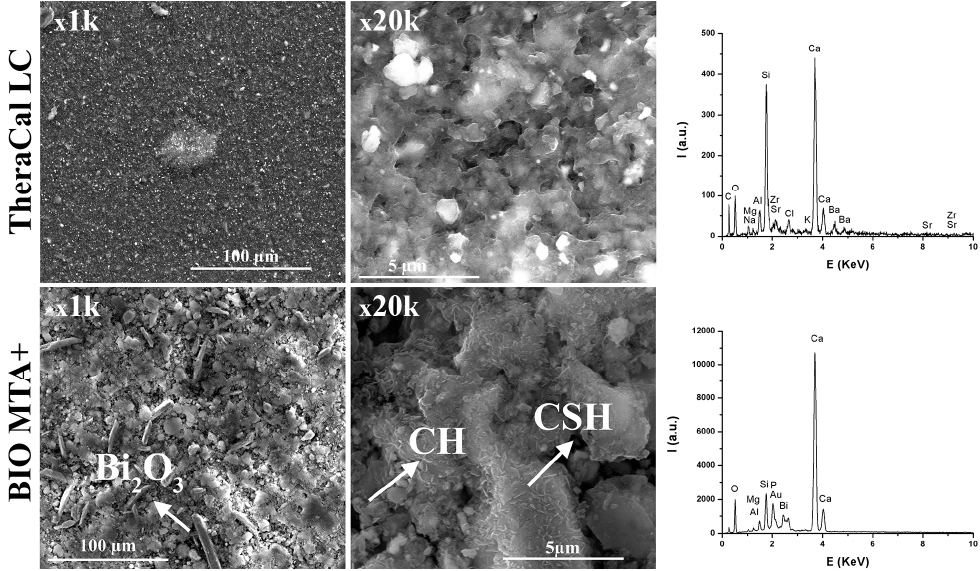
Figure 4. Scanning electron micrographs at different magnifications and EDX spectra of TheraCal and BIO MTA+ surfaces at three days .